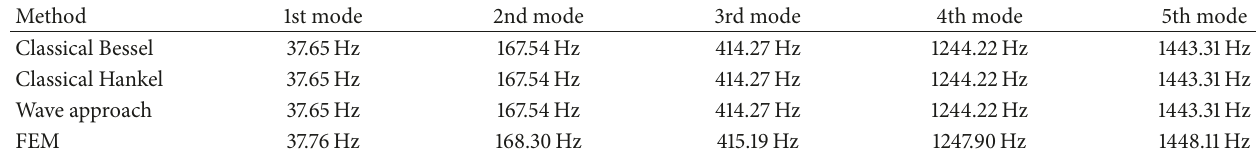
Table 2: Results calculated by classical method, wave approach, and FEM.